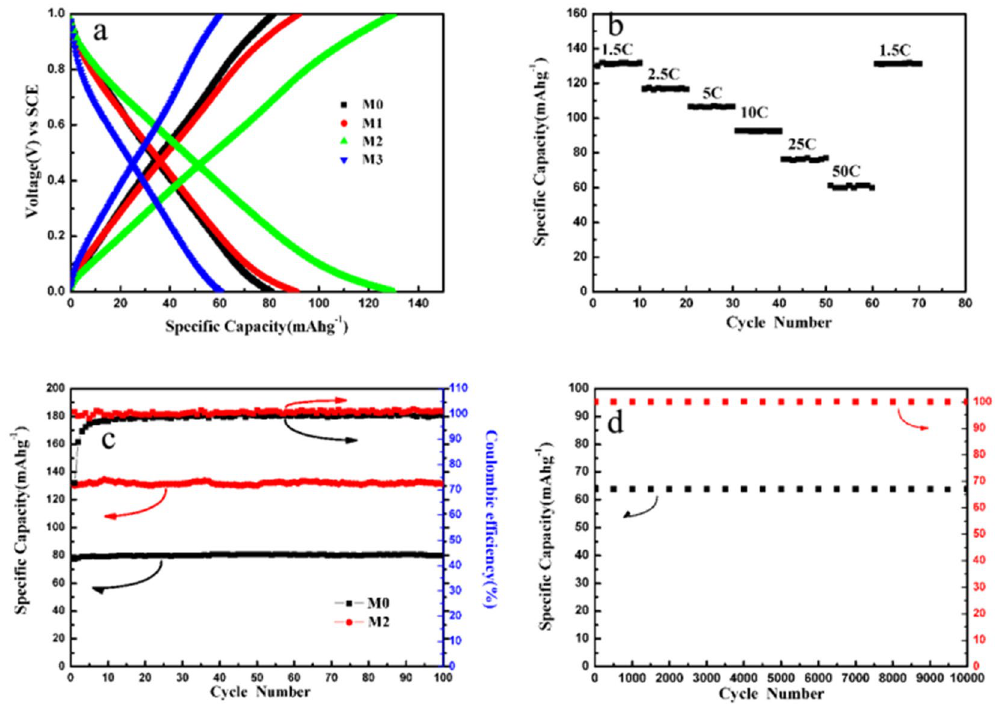
Figure 3. ( a ) Charge-discharge profiles of the as-prepared manganese oxides at 1.5 C, ( b ) Rate performance of M2 electrode, ( c ) Cycling performance of M0 and M2 electrodes at 1.5 C, and ( d ) Long cycling stability of M2 electrode at 50 C.